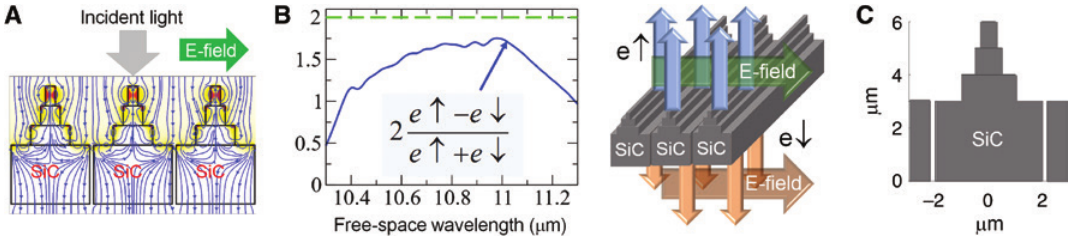
Figure 24: Extreme absorption/emission control with LSPhPs. (A) TM-polarized light gets near-perfectly absorbed with a SiC micropyramid array in the reststrahlen band of SiC by virtue of a cascaded coupling effect of the LSPhPs from the tip-to-the base SiC blocks. (B) Corresponding highly-asymmetric emissivity, e, of the micropyramid array. A value of 2.0 for the asymmetry factor defined in the inset implies a perfect uni-directional emission (C) Structural size details for the micropyramid array design (zoomed around the middle micropyramid). (After